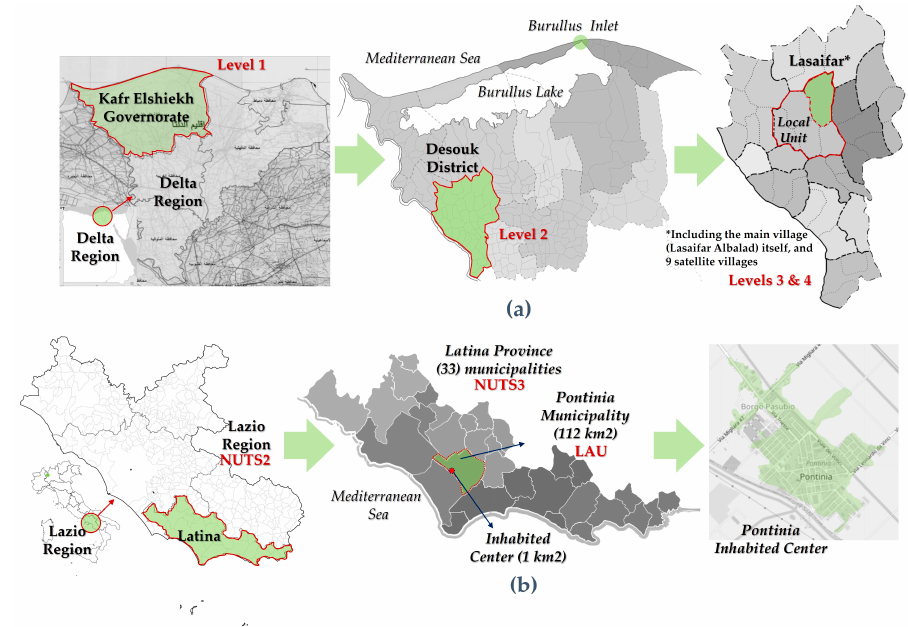
Figure 11. ( a ) The Egyptian case study, from the ultimate context to the intimate context; ( b ) The Italian case study, from the ultimate context to the intimate context.